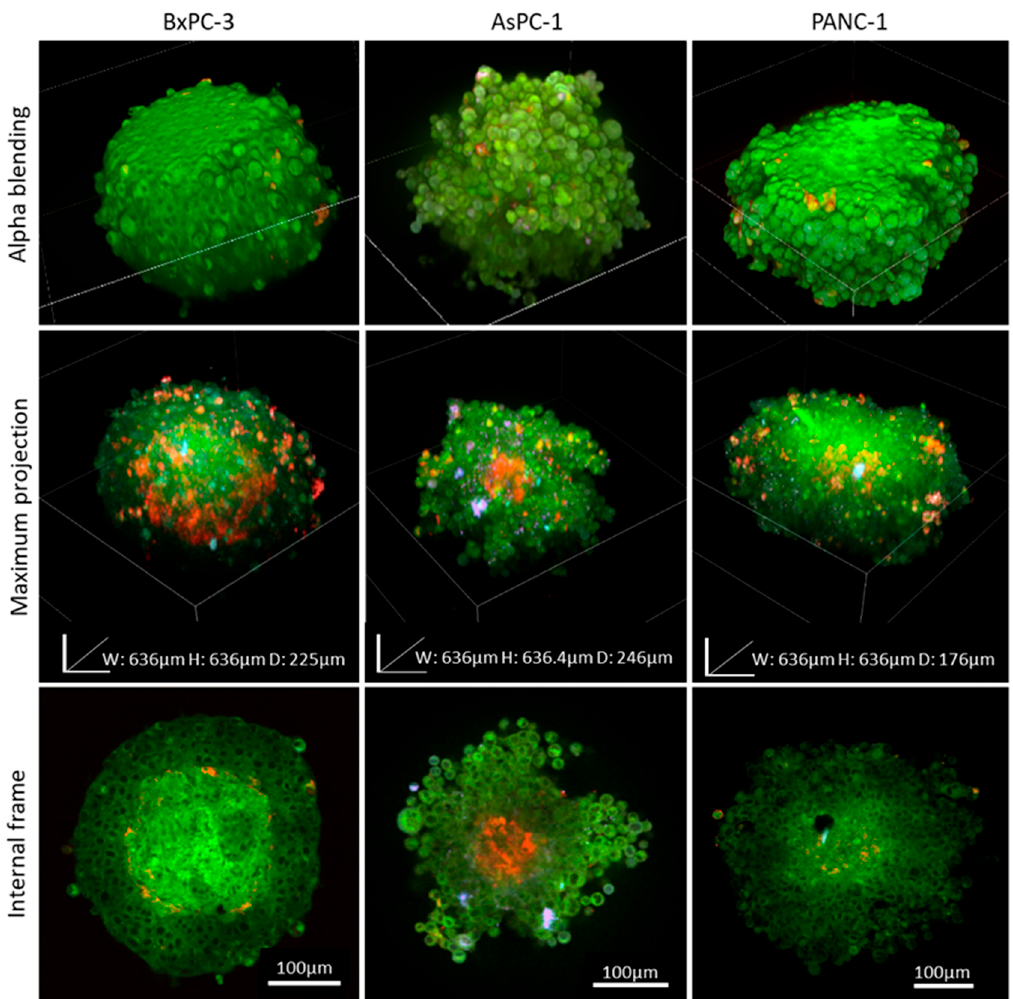
Figure 5. Co-cultured spheroids mimic the tumor microenvironment. Co-cultured spheroids comprised of 10,000 cells at a ratio of 6:2:2 of pancreatic cancer cells: patient-derived pancreatic cancer fibroblasts: HUVECs, respectively. Samples were fixed 4 days after seeding and immunolabeled with anti-CD31 (red), anti-fibroblasts (purple), and Coumarin-6 (green), and imaged post-clearing.